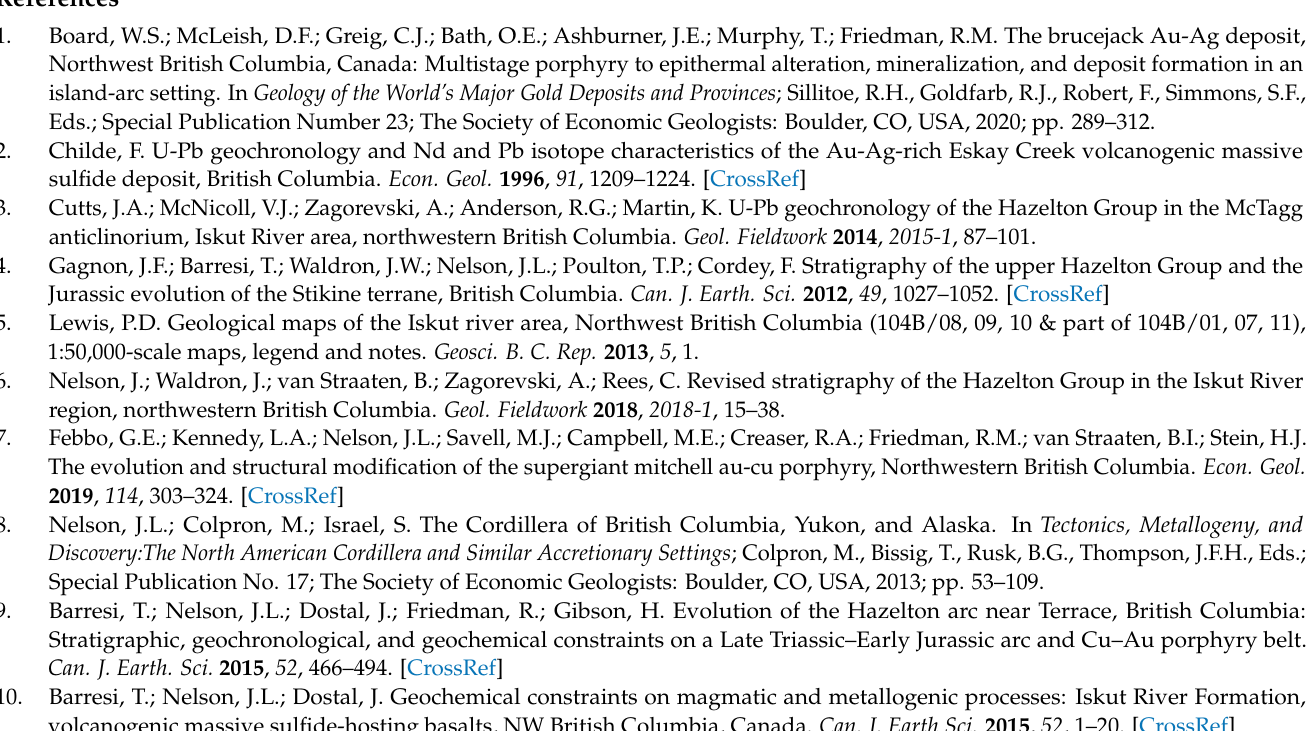
Table S2c: Precision (RSD) and accuracy (RD) for reference materials (RMs) used for major, minor and trace element lithogeochemistry, Table S3: Results of SIMS measurement on in-house muscovite and quartz RMs, Table S4: Results of whole rock lithogeochemistry and calculated parameters, Table S5: Mineralogical composition altered felsic flows from XRD analyses, Figure S1. Mineralogical composition of altered felsic flows, Table S6a: K-feldspar composition with calculated mineral formula in altered felsic flows, Table S6b: Illite composition with calculated mineral formula in altered felsic flows, Table S6c: Pyrite composition with calculated mineral formula in altered felsic flows, Table S7: Calculated fluid temperature using illite composition for all drill